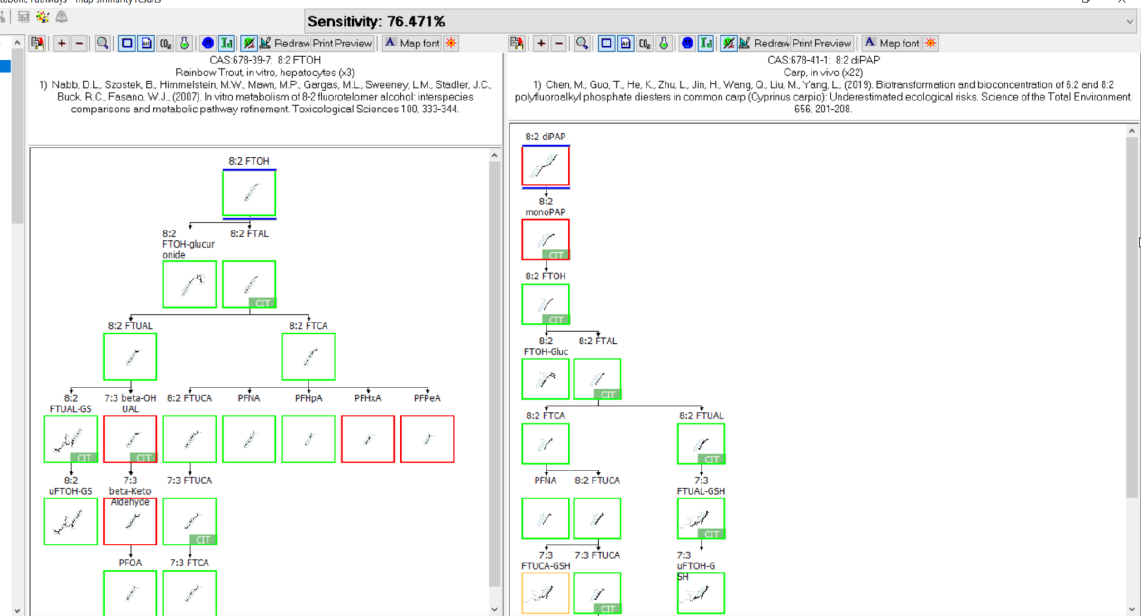
Figure 19. Metabolic map comparison of ( left ) 8:2 FTOH in rainbow trout hepatocytes and ( right ) 8:2 diPAP in vivo carp. Metabolites common to both species are indicated by green boxes. Differences in metabolites are indicated by red boxes. Tan boxes indicate phase II conjugates. Sensitivity, in this case 76.471%, is an assessment of the map comparison whereby the number of common metabolites is divided by the total number of metabolites in the fish map. Metabolites labeled with CIT are presumed intermediates in the path but were not identified in the study.